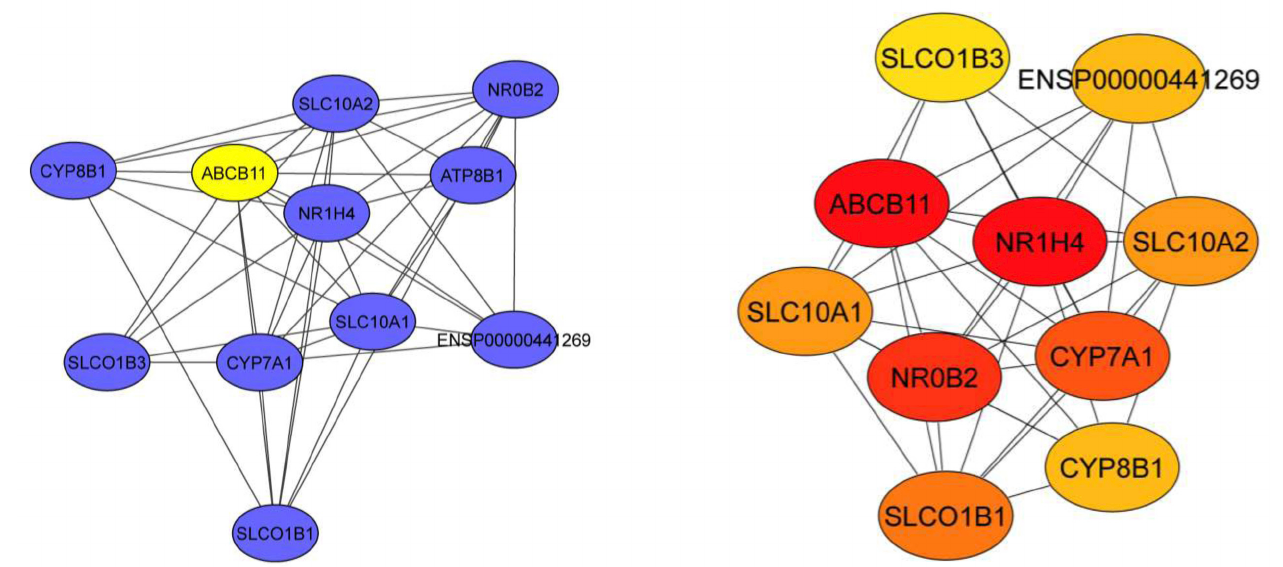
Figure 3. A protein-protein interaction network of the ABCB11 gene was constructed using the STRING app in Cytoscape with confidence score > 0.4 for Homo sapiens . This network was constructed to analyze the relationship between ABCB11 and other proteins. Cytohubba app was used to calculate centrality of each node by MCC method. Node colour (red to yellow) represents the significance of the centrality in the group. In this analysis, we counted 11 nodes and 42 edges. These proteins majorly involved in bile acid metabolism and transport. Most of these genes are participant of more than one pathway which was expected because these pathways intersect and coregulated. We also mapped the NR0B2 protein, which is participate in sterol metabolism.